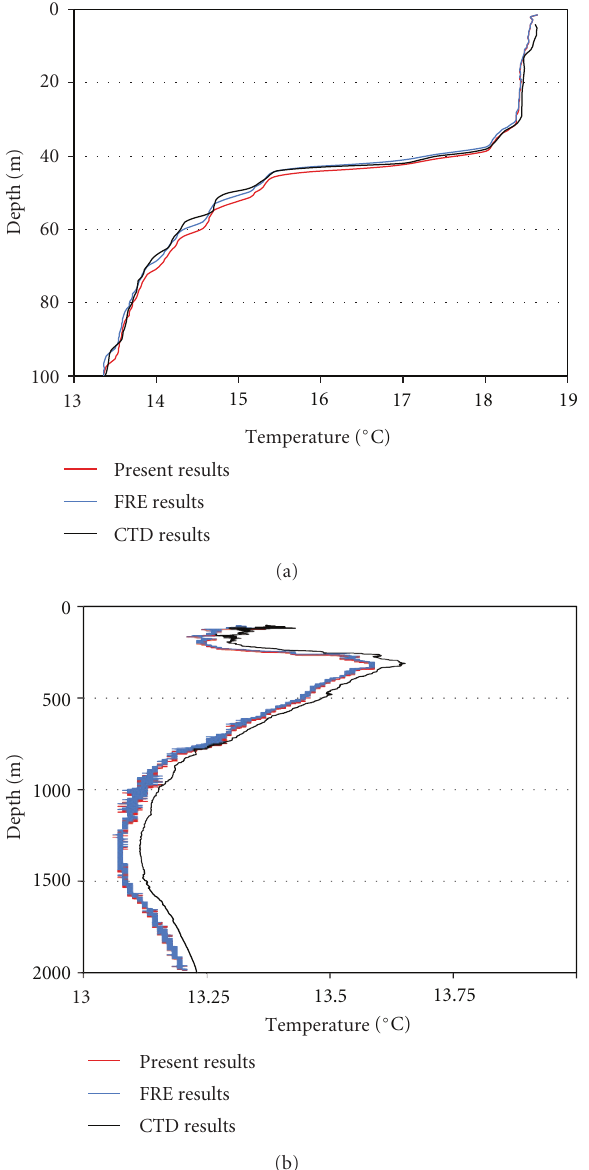
Figure 9: An additional comparison of the present method and the manufacturer FRE with a collocated CTD